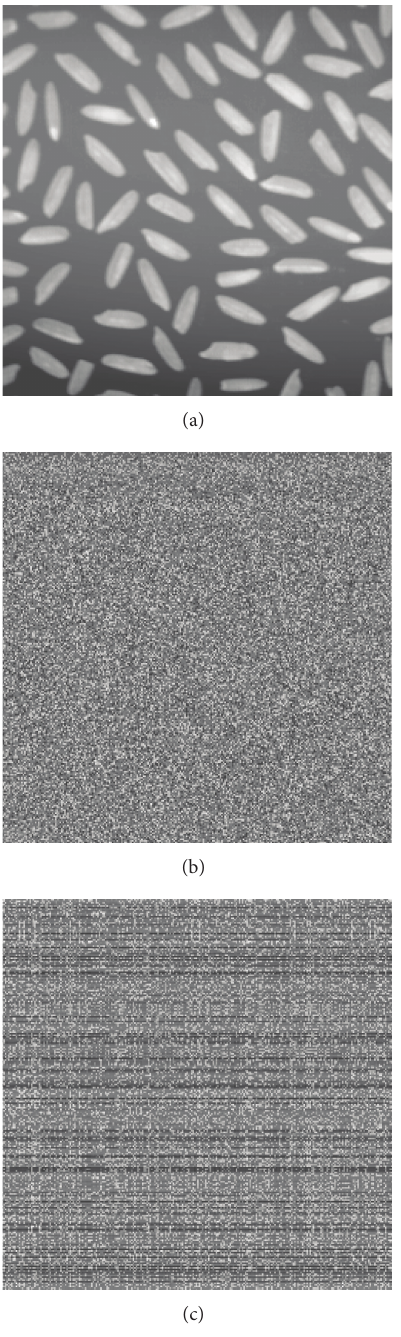
Figure 1: Encryption: (a) plain-image of Rice, (b) shuffled image using our method, and (c) shuffled image using traditional method.